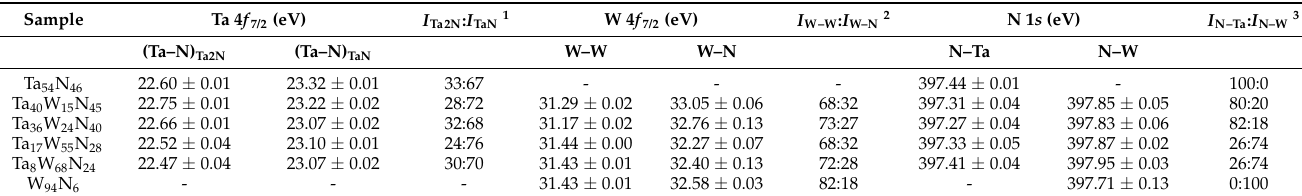
Figure 6. ( a ) Ta, ( b ) W, and ( c ) N signals at a depth of 49.8 nm for the TaWN films. Table 2. XPS analysis results for the TaWN films at depths of 16.6–49.8 nm.